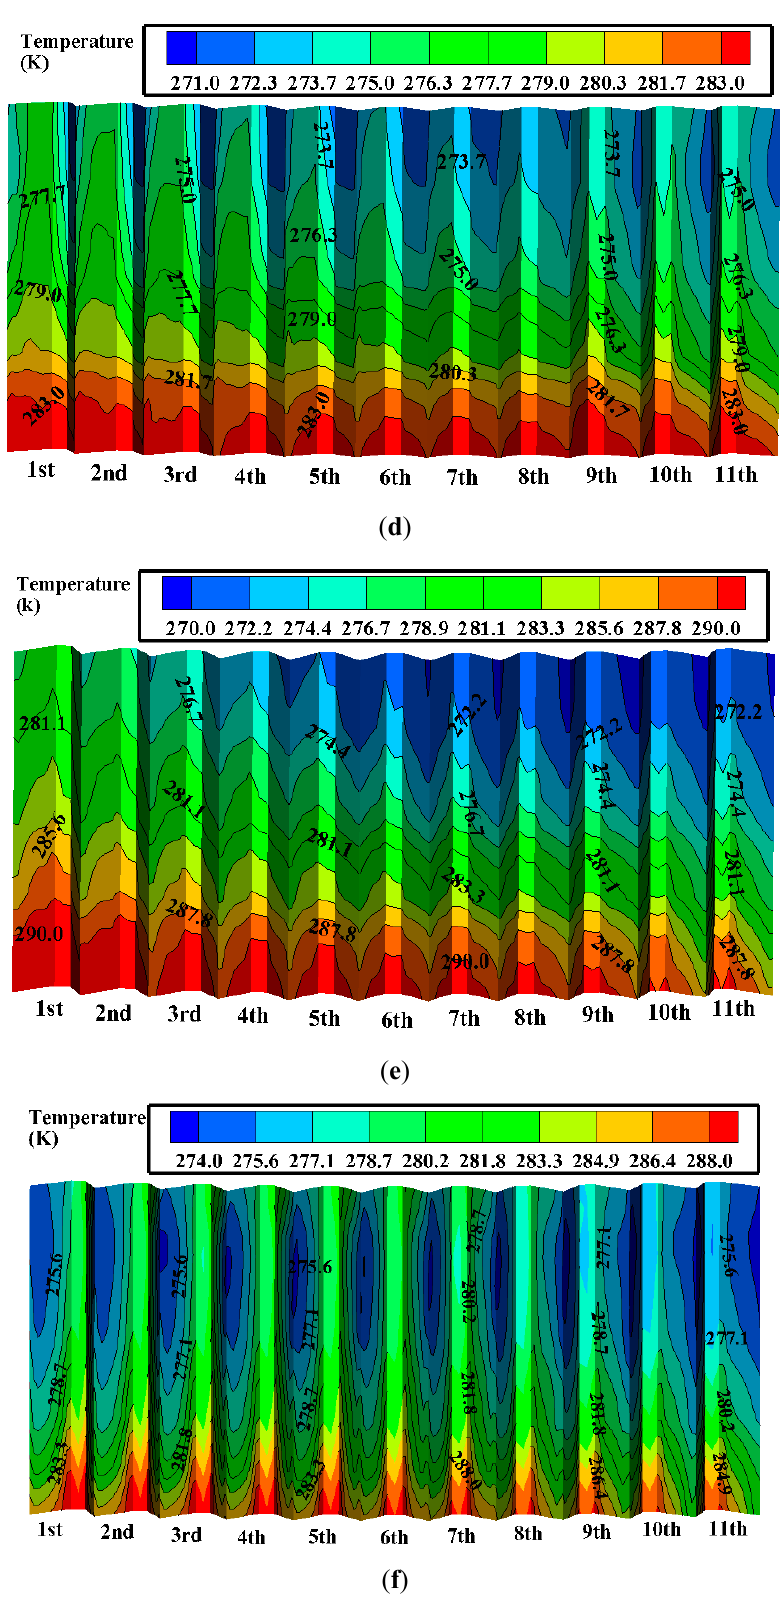
Figure 16. Variable fields of the leeward deltas. ( a ) Pressure and flow fields at 4 m/s, ( b ) pressure and flow fields at 12 m/s, ( c ) pressure and flow fields at 16 m/s, ( d ) outlet air temperature at 4 m/s, ( e ) outlet air temperature at 12 m/s, ( f ) outlet air temperature at 16